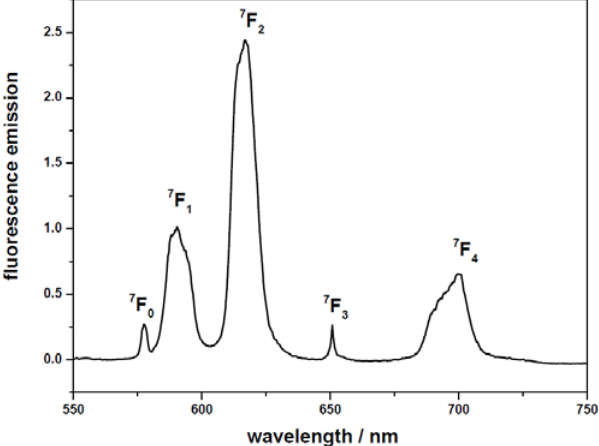
Figure 2. Eu 3+ fluorescence spectroscopy in aqueous solution. Different peaks represent different electron transition. [Eu] = 4.1  10 -6 mol/L, pH = 4.0 ± 0.1, T = 20 ± 1